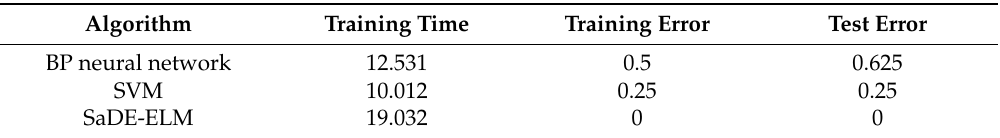
Table 2. Performance comparison of different algorithms for fault diagnosis of the marine fuel